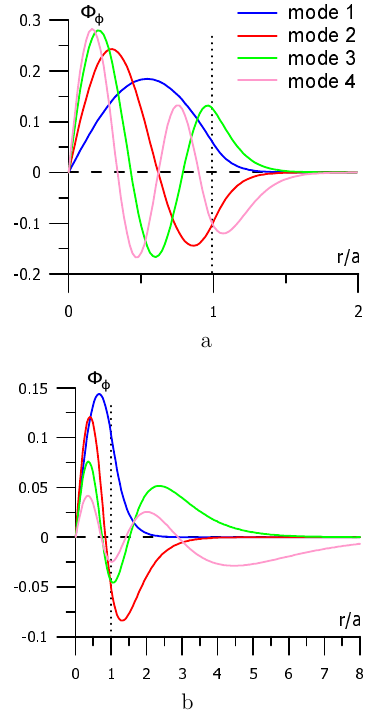
Fig. 3. Examples of the eigenmode transverse structure in the cases of wide ( a ) and narrow ( b ) ducts for the same parameter values as in Fig. 2 and ω/ω BL = 0 . 14. Eigenmode indexes are shown on the legend; the boundary of the duct core is marked by a dotted /ω B = 15, d